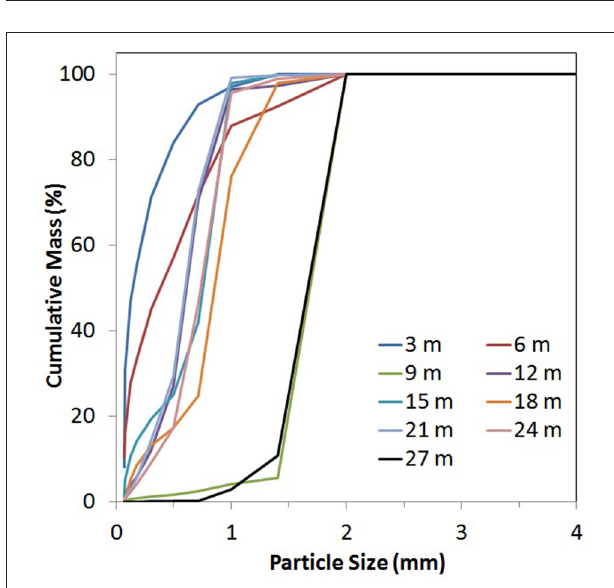
FIGURE 3 | Particle size distribution of the NUC well at 3-m depth